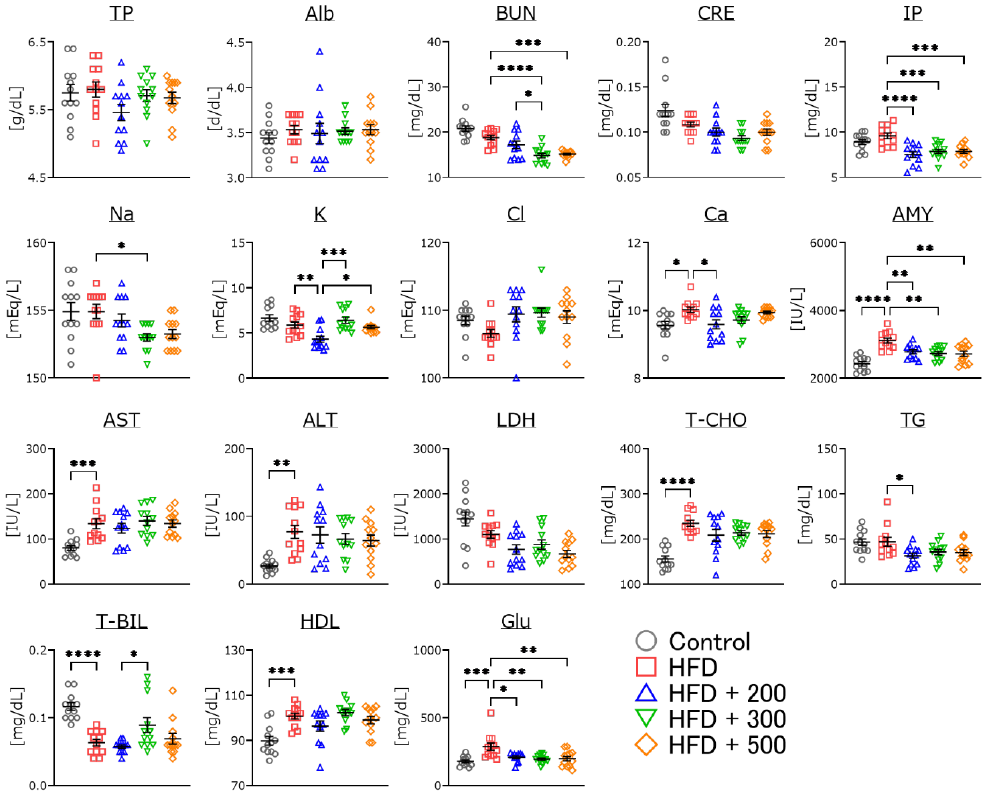
Figure 5. Changes in serum parameters for control, HFD-treated and HFD-plus DSW-extract-added water-treated mice. Control (Ctrl, n = 12), high fat diet (HFD, n = 12), HFD + DSW-extract-added water hardness 200 (HFD + 200, n = 12), HFD + DSW-extract-added water hardness 300 (HFD + 300, n = 12), HFD + DSW-extract-added water hardness 500 (HFD + 500, n = 12). The data are shown as means ± SE. * p < 0.05, ** p < 0.01, *** p < 0.001, **** p < 0.0001. Comparisons were performed using